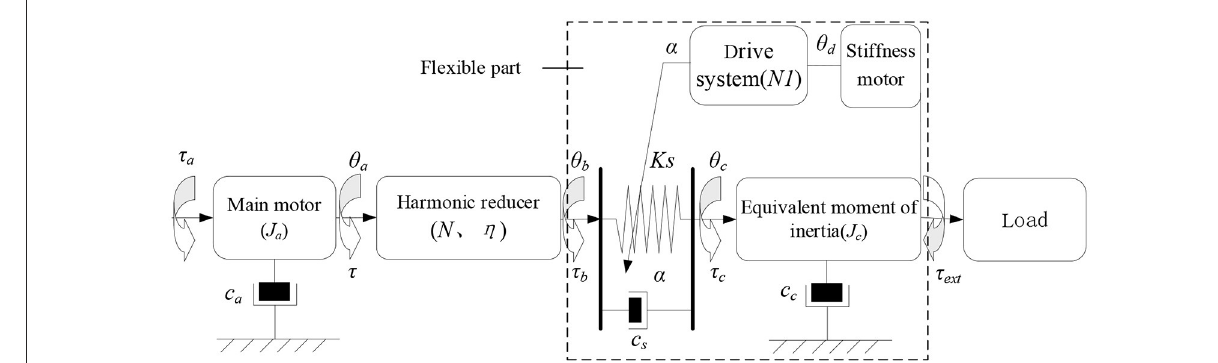
FIGURE6 Dynamic model of elbow joint with variable stiffness.